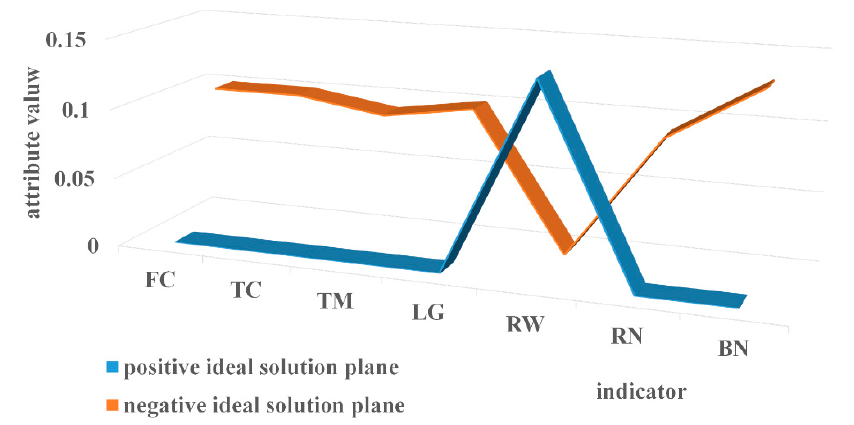
Figure 11. Positive and negative ideal solution planes.